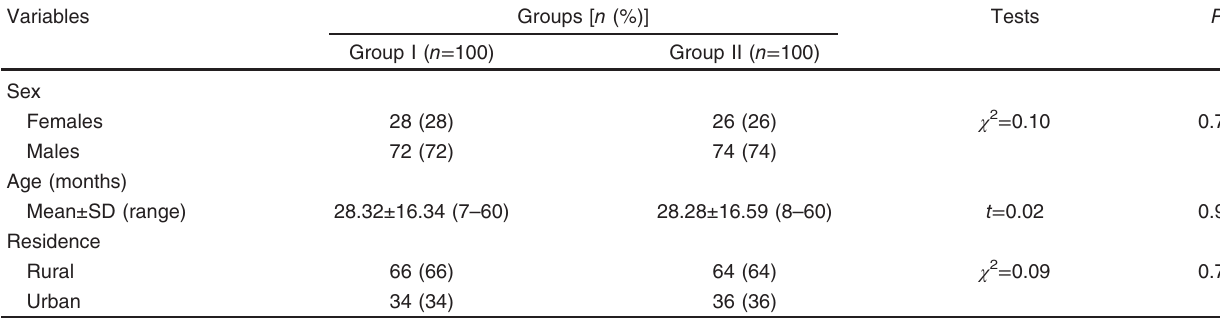
Table 1 Sociodemographic characteristics of studied children Variables Groups [ n (%)]